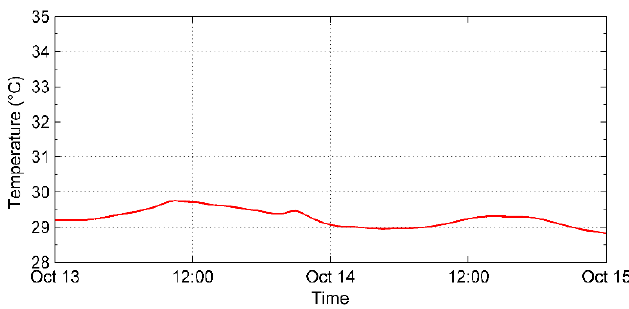
Figure 15. Temperature signal at the intake of the CTPALM.